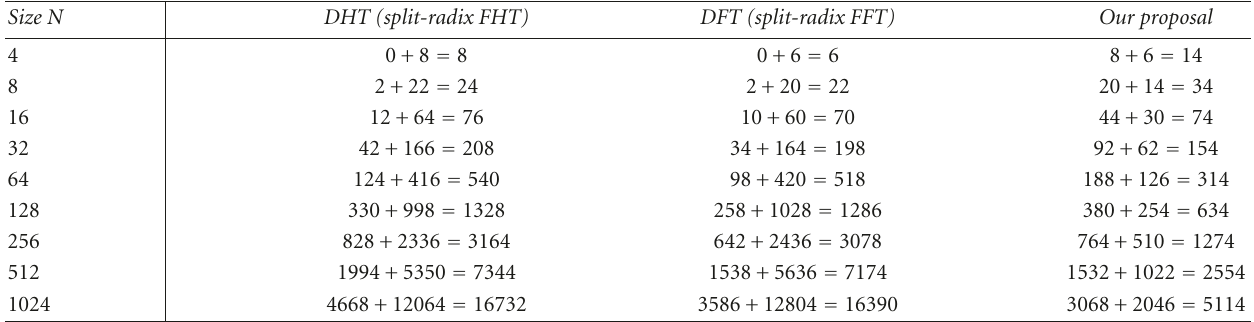
Table 12: Lowest known operation counts (real multiplications + additions) for power-of-two DHT and corresponding DFT algorithms versus our proposal (weighted sums + simple